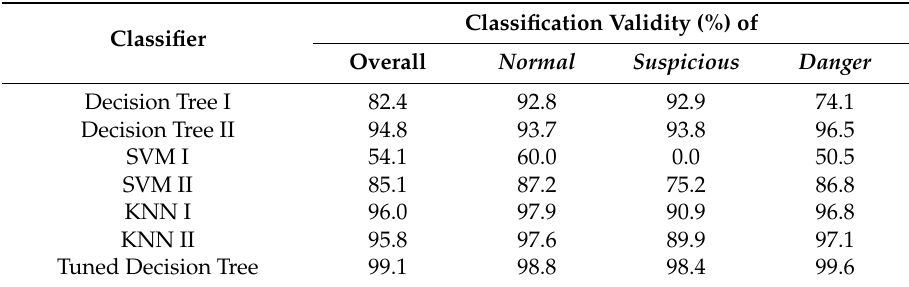
Table 5. Classification validity of validated machine learning